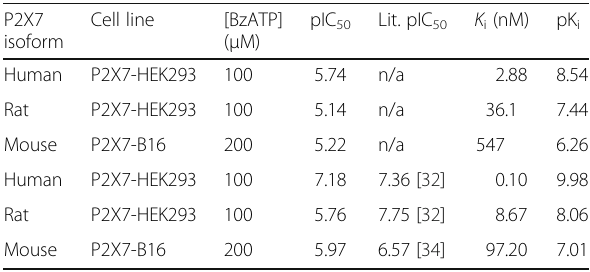
Table 6 EFB and A-740003 calcium influx inhibition of P2X7